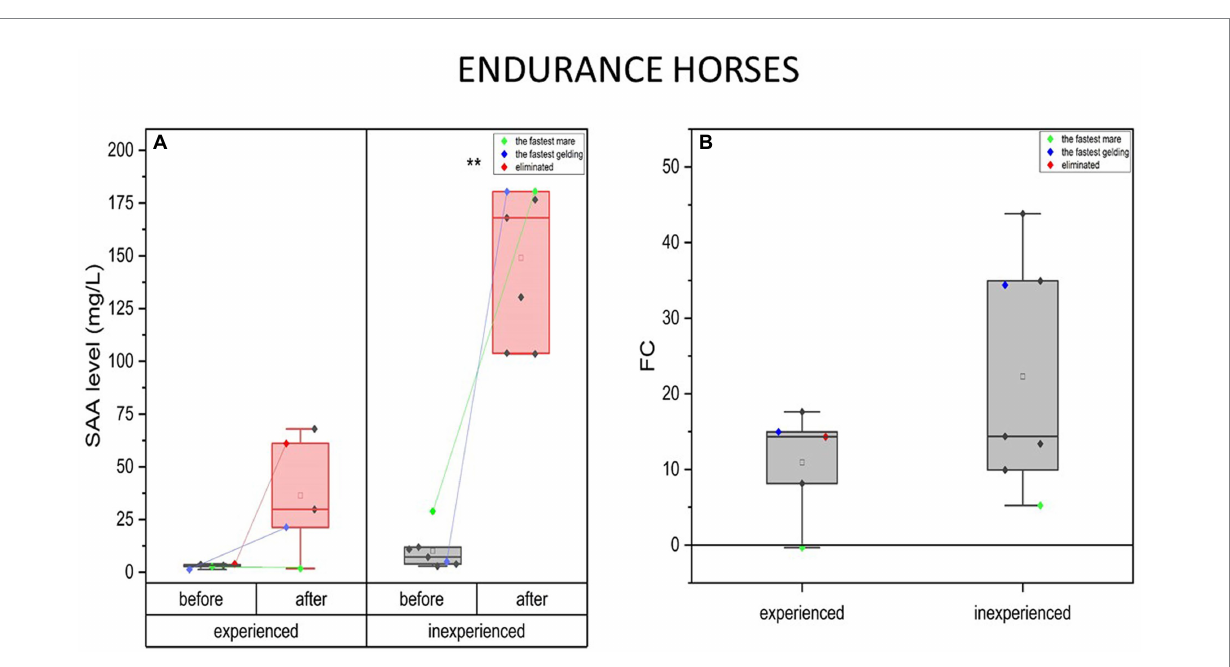
FIGURE 8 Changes in SAA plasma concentration upon training in experienced ( n = 5) and inexperienced ( n = 7) endurance horses. Colored data points indicate the fastest mare (green), the fastest gelding (blue), and the eliminated gelding (red). Box plots (IQR, mean and median; whisker range within 15IQR) are expressed as differences in molar plasma concentration (A) and fold change (FC) (B) . Statistically significant differences are indicated by asterisks at p < 0.05 (*), p < 0.01 (**), and p < 0.001